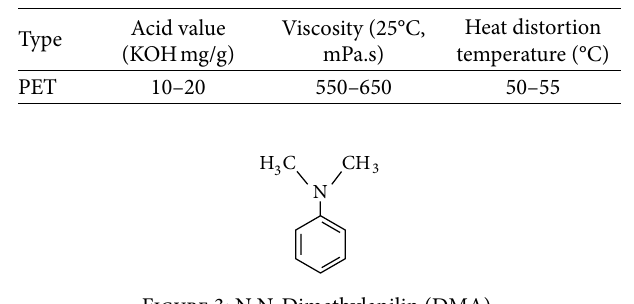
Figure 2: PET unsaturated polyester resin. Table 1: Resin liquid index.